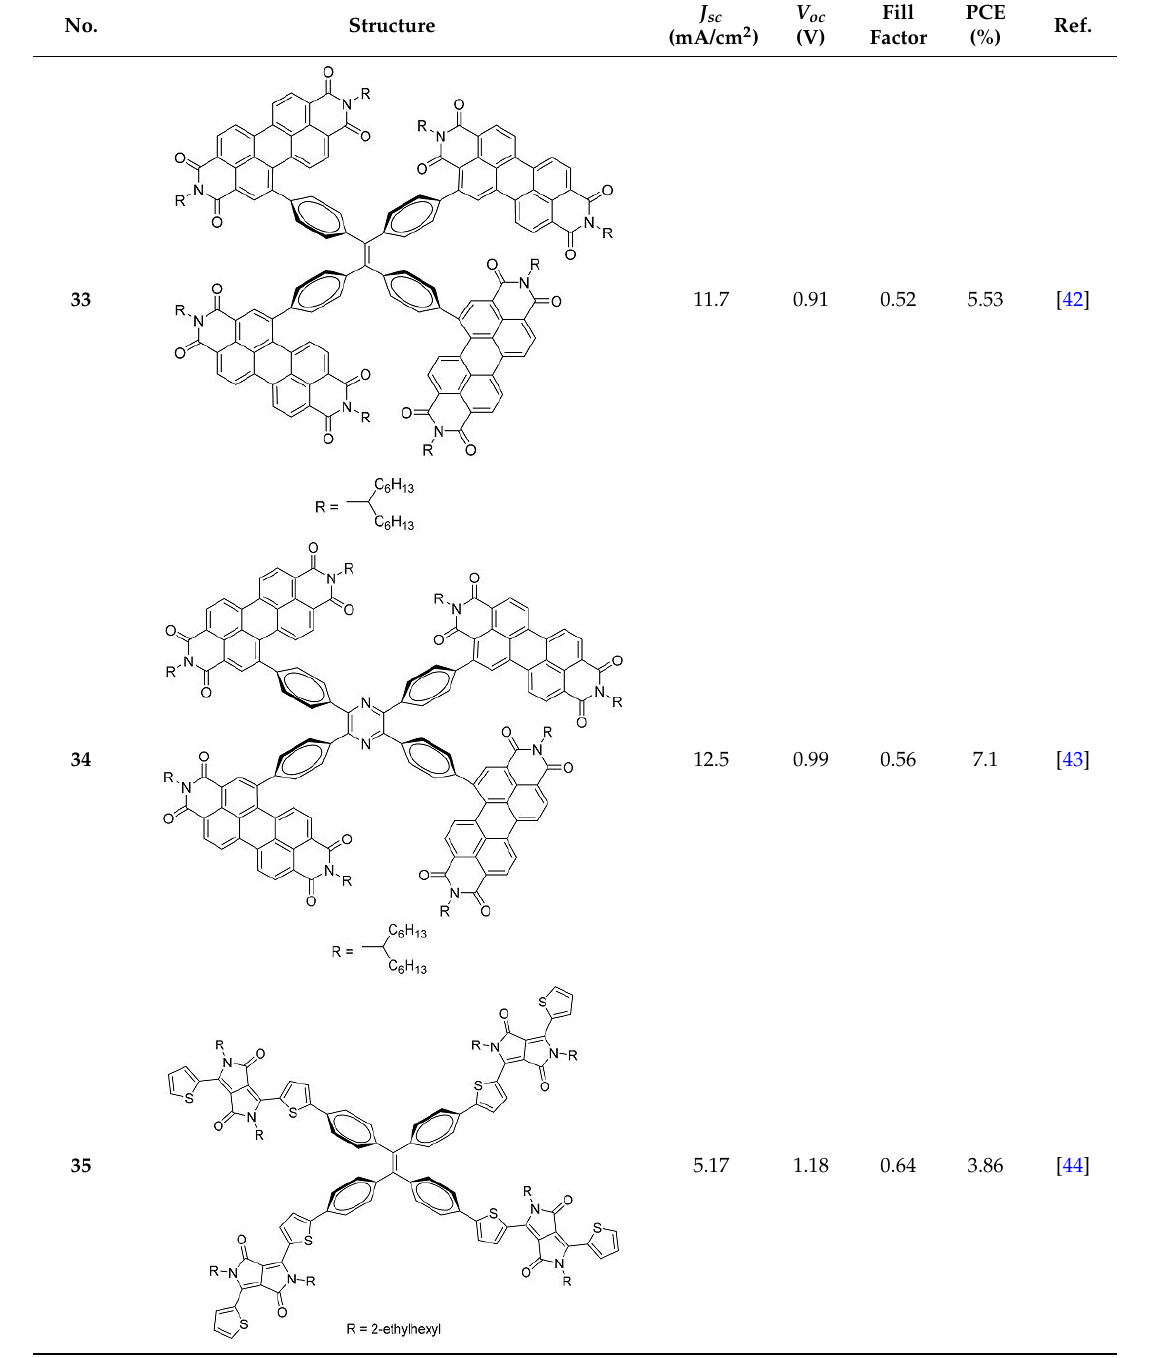
Table 3. Structures of OPV molecules containing AIE